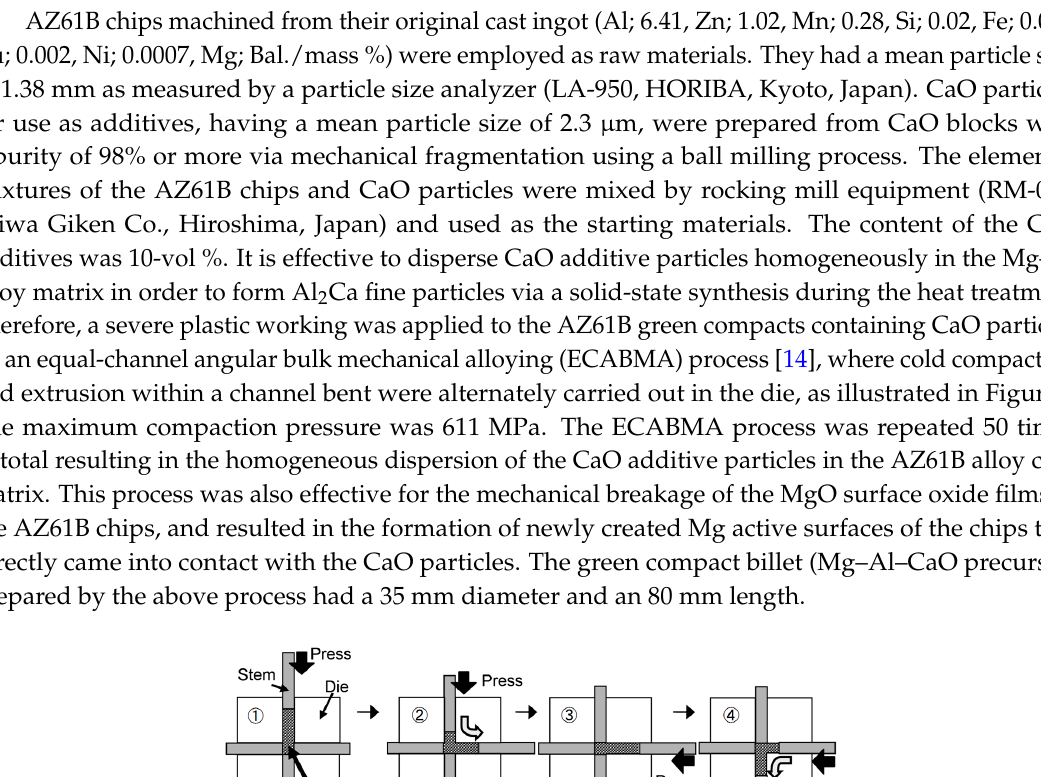
Figure 3. Schematic illustration of one cycle of equal channel angular bulk mechanical alloying (ECABMA)